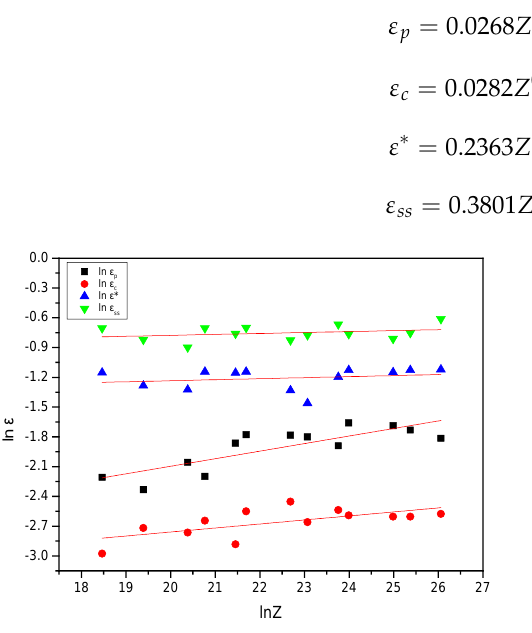
Figure 8. Dependences of 𝜀 𝑝 , 𝜀 𝑐 , 𝜀 ∗ and 𝜀 𝑠𝑠 on parameter Z .